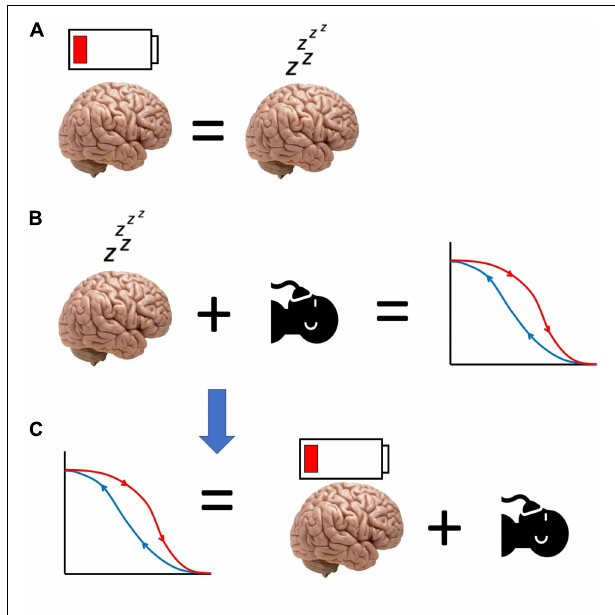
FIGURE 3 | Schematic of our hypothesis equating neural inertia with post-anaesthetic sleep inertia. (A) Sleep inertia (represented by the depleted battery icon over the brain) is neurally and behaviourally equivalent to sleepiness. (B) Sleepiness reduces the need for anaesthetic, and increases post-anaesthetic neural inertia. Therefore, (C) neural inertia may be seen as the manifestation of sleep inertia occurring after anaesthesia, reducing the amount of anaesthetic that is needed for the brain to be